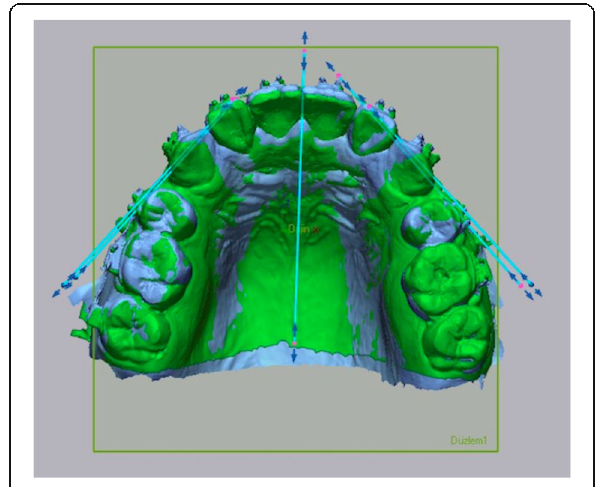
Fig. 6 Method of rotation measurement